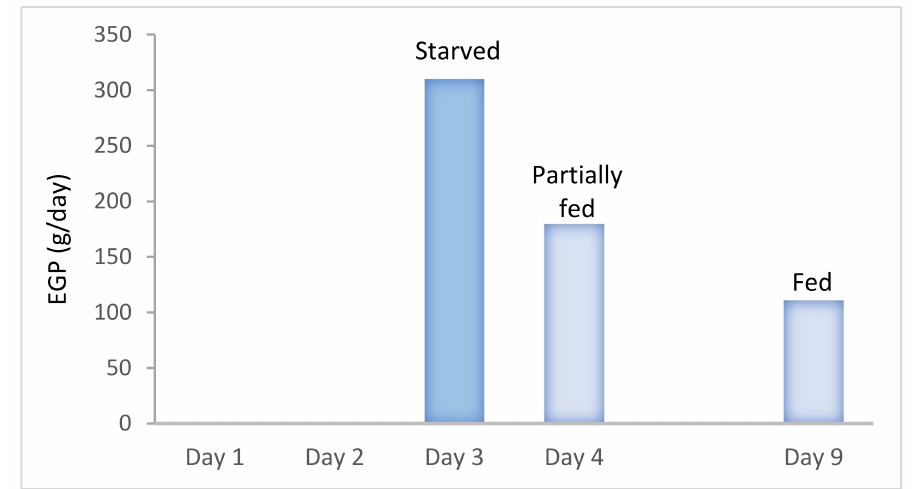
Figure 6. Evolution of the endogenous glucose production (EGP) over time in critically ill patients. EGP was shown to be 310 g / day in 40 years old starved trauma patients at day 3 of ICU admission (blue) [37] and then decreased to 180 and 111 g / day in older fed patients at day 4 and 9 respectively (light blue) [8]. EGP has to be considered as source of energy in order to avoid overfeeding by extrinsic energy during the first days of ICU stay. Data combined from